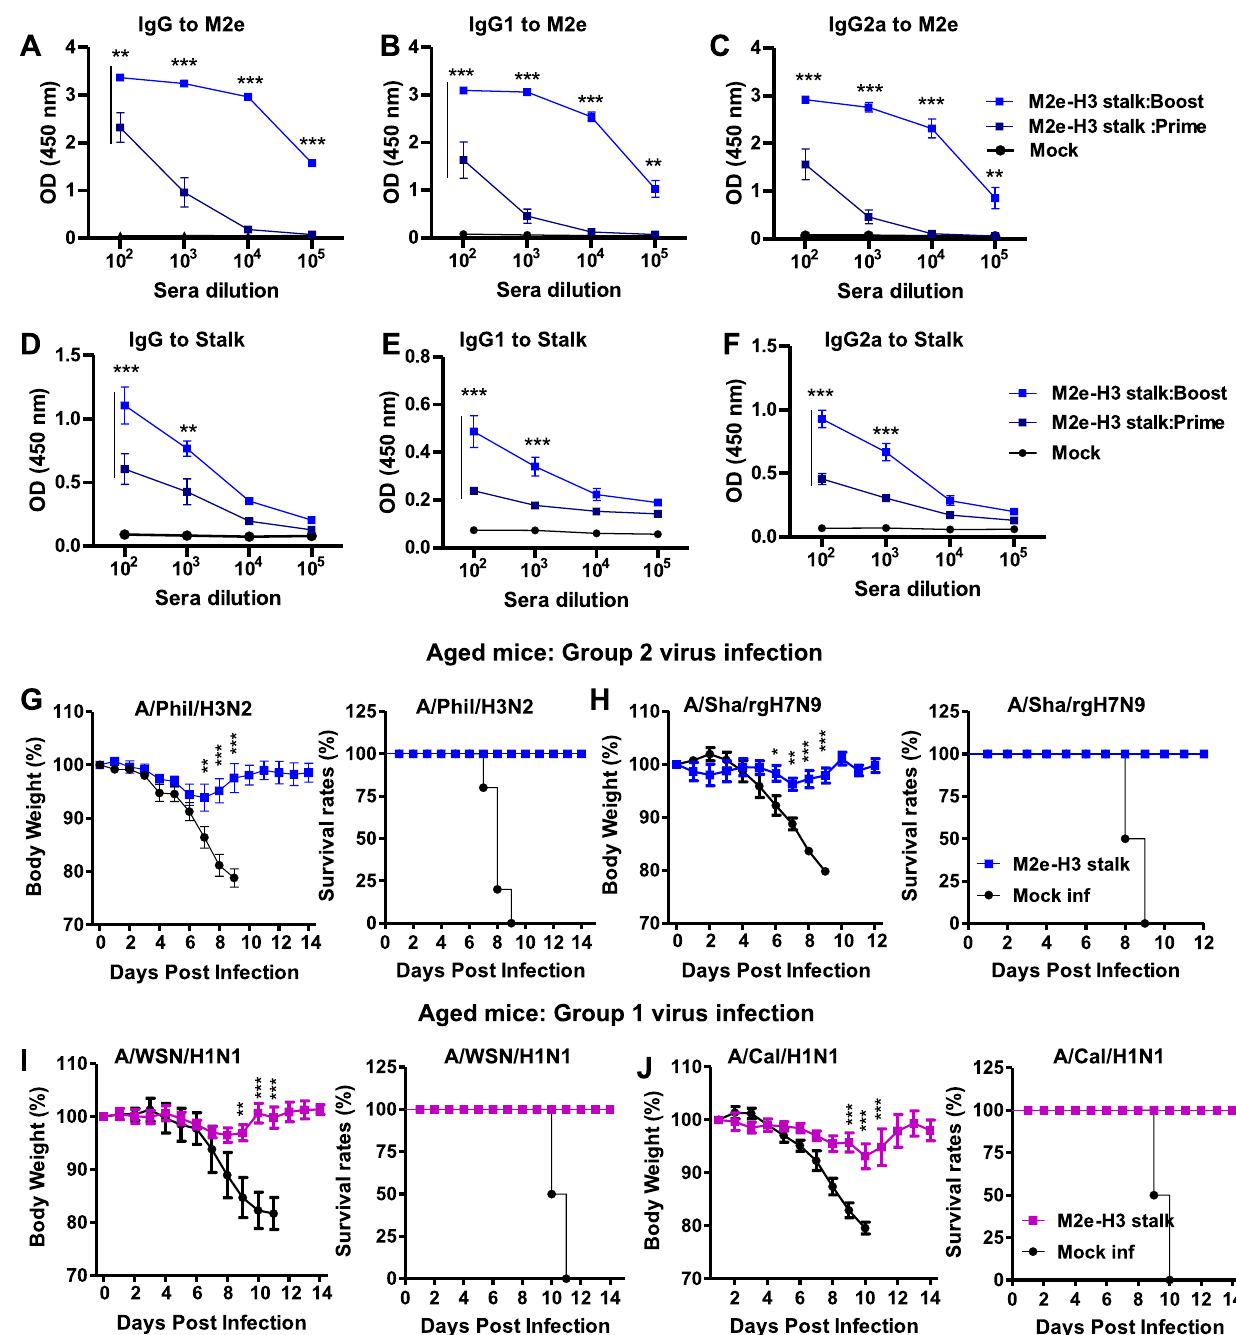
Fig. 8 Aged mice with adjuvanted M2e-H3 stalk vaccination induces cross-group virus protection. Aged mice (16 months old, n = 5) were i. m. prime-boost immunized with adjuvanted M2e-H3 stalk protein. A – F M2e-H3 stalk vaccination of aged mice induced IgG, IgG1 and IgG2a antibodies against M2e and stalk protein. IgG to M2e ( A ), IgG1 to M2e ( B ), IgG 2a to M2e ( C ). IgG to stalk ( D ), IgG1 to stalk ( E ), IgG 2a to stalk ( F ). G – J Ef fi cacy of cross-group virus protection in aged mice as measured by body weight changes and survival rates. Aged mice ( n = 5) at 3 weeks after boost vaccination were intranasally challenged with a lethal dose of either group 1 (A/WSN H1N1, A/Cal H1N1) or group 2 (A/Phil H3N2, A/Sha/ H7N9) in fl uenza A viruses. A/Phil H3N2 ( G ), A/Sha/ H7N9 ( H ), A/WSN H1N1 ( I ), A/Cal H1N1 ( J ). Statistical signi fi cance was determined using the two-way ANOVA followed by Bonferroni post-test. Error bars indicate means ± SEM; * P < 0.05; ** P < 0.01; *** P < 0.001. data of M2e-H3 stalk suggest the presentation of native-like protection, we designed a chimeric M2e-H3 stalk construct conserved epitopes to be exposed for recognition by Abs speci fi c expressed in E. coli . The M2e-H3 stalk contains M2e repeat, HA1 for both group 1 and 2 HA and antisera from infection with live stem-interacting fragments, HA2 aa1-117 stem domain composed viruses in addition to M2e and stalk. of fusion peptide with membrane proximal β -strands, helix A, loop Full-length H3 stalk (aa 1-172) proteins with point mutations B with point mutations, and helix C, which covers most epitopes to retain prefusion-like conformation and headless HA1 known for broadly neutralizing stalk mAbs (Fig. 1D). Antigenicity npj Vaccines (2022) 68 Published in partnership with the Sealy Institute for Vaccine